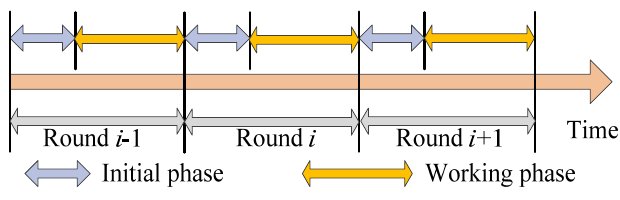
Figure 3. Division of the time rounds.